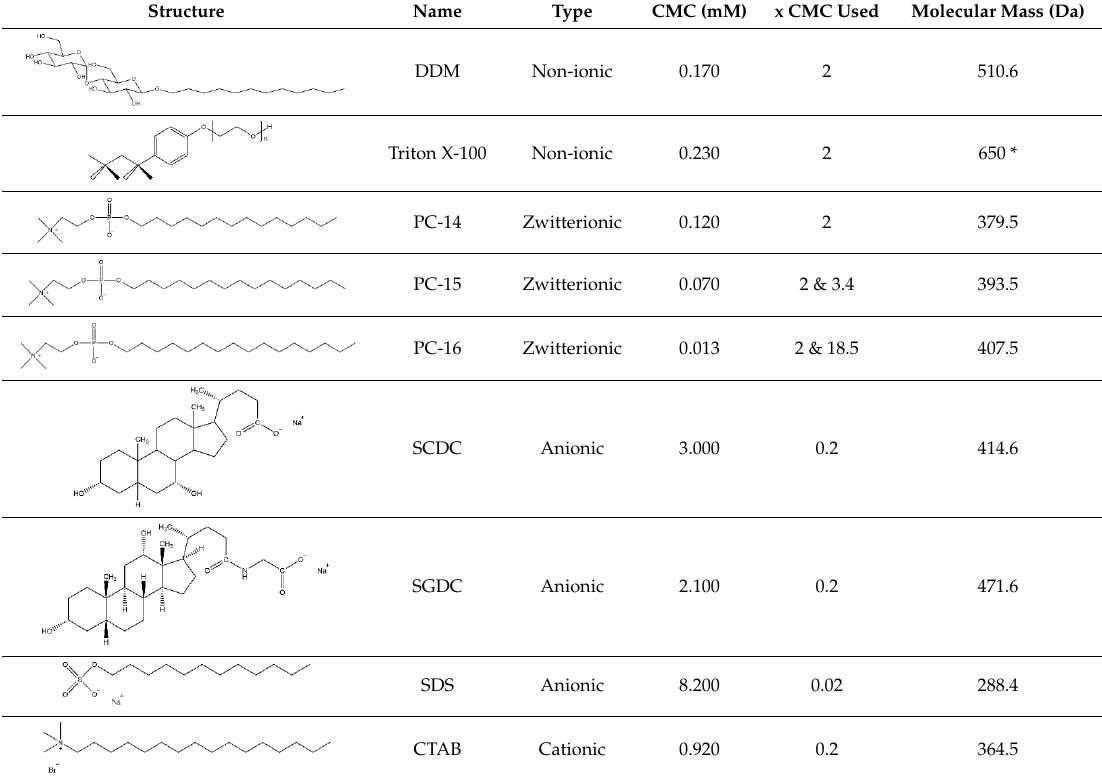
Table 2. Overview of the chemical structure of detergents used together with the type, CMC, standard experimental concentration and molecular mass. * The exact molecular mass of Triton X-100 varies as the chain can have a different number of ethylene oxide groups, adding 44 Da for each additional group.